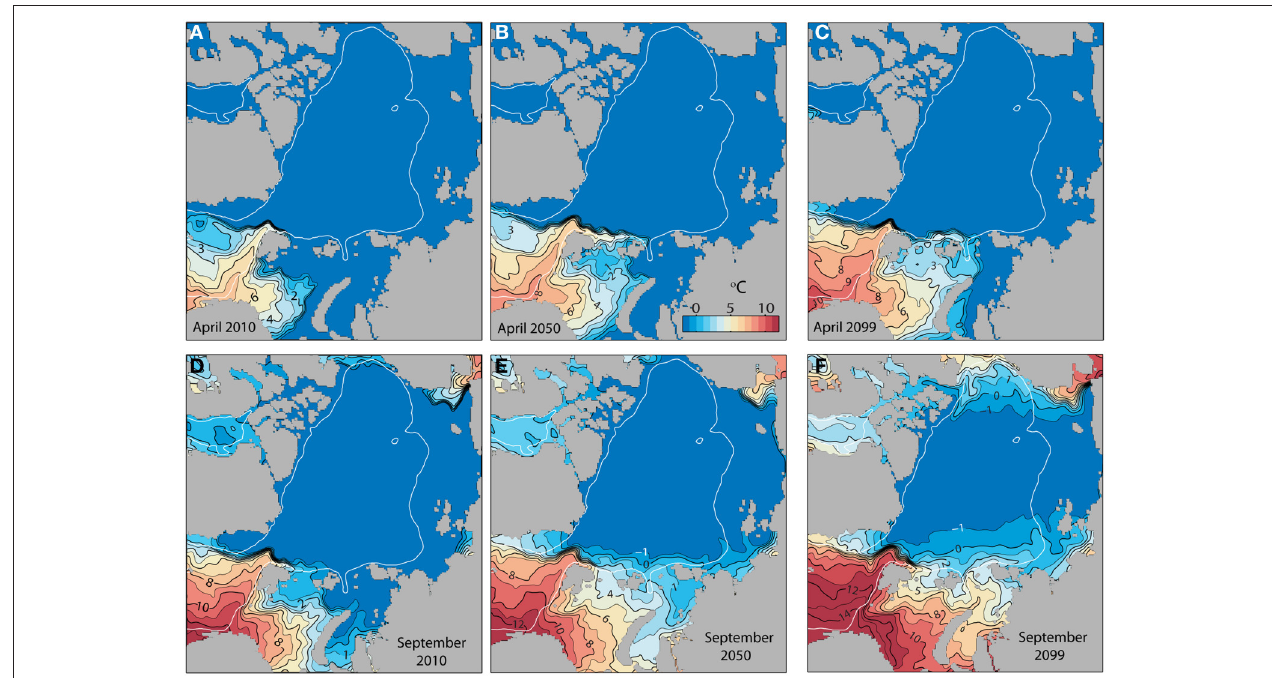
FIGURE 10 | Monthly simulated mean surface water temperatures at the start of the productive period in April (upper panel) and at the end, September (lower panel) in the entire Arctic Ocean (A1B) at present (2010), in 2050 and 2099 ( ◦